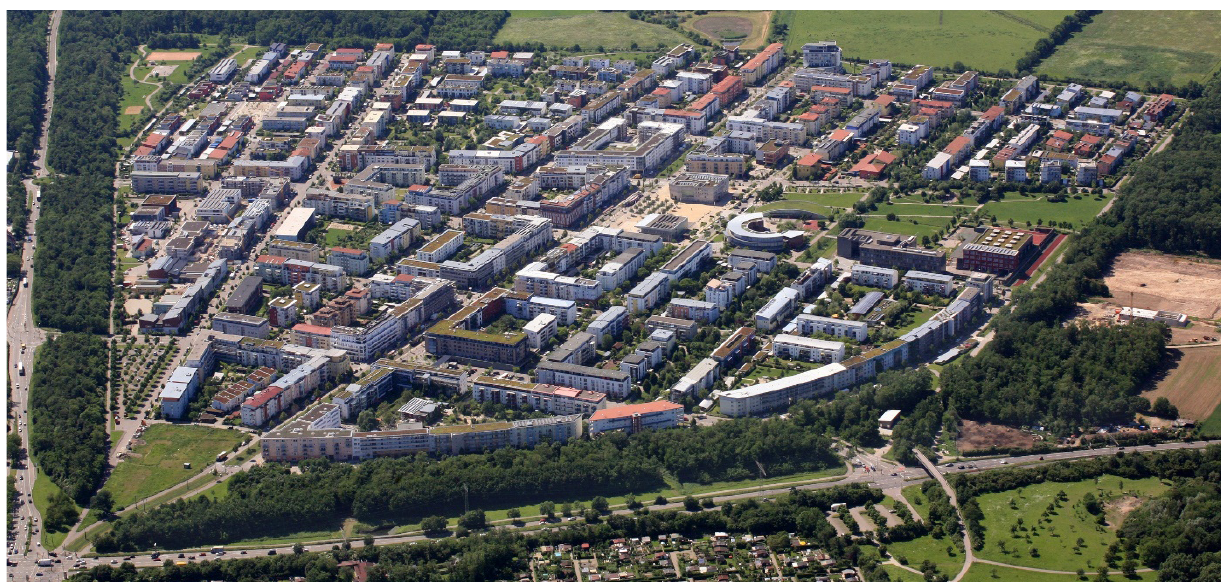
Figure 2. Aerial view of Rieselfeld neighborhood in